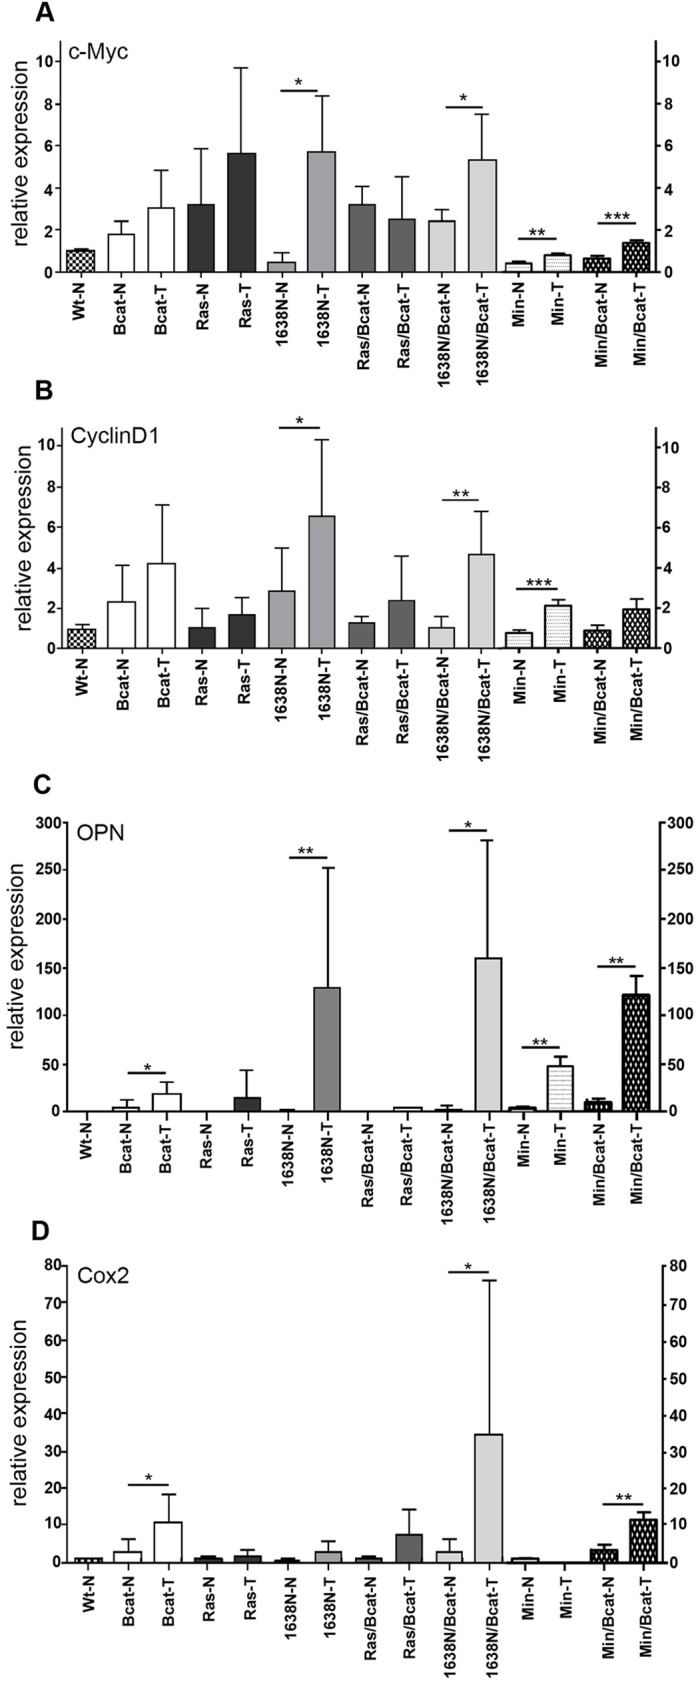
Regulation of selected Wnt target genes in tumors of mice of the indicated genotype where no difference in proliferation is detected upon expression of the
ΔN-Bcat
transgene. (A,B) RT-qPCR analysis of Myc and cyclinD1 mRNA expression in normal (N) and tumor (T) tissue from mice of the indicated genotypes (*P<0.05, **P<0.01, ***P<0.001; n≥5 tumors). (C,D) RT-qPCR analysis of osteopontin (OPN) and cyclooxygenase 2 (Cox2) mRNA expression in normal (N) and tumor (T) tissue from mice of the indicated genotypes (*P<0.05, **P<0.01; n≥5 tumors).